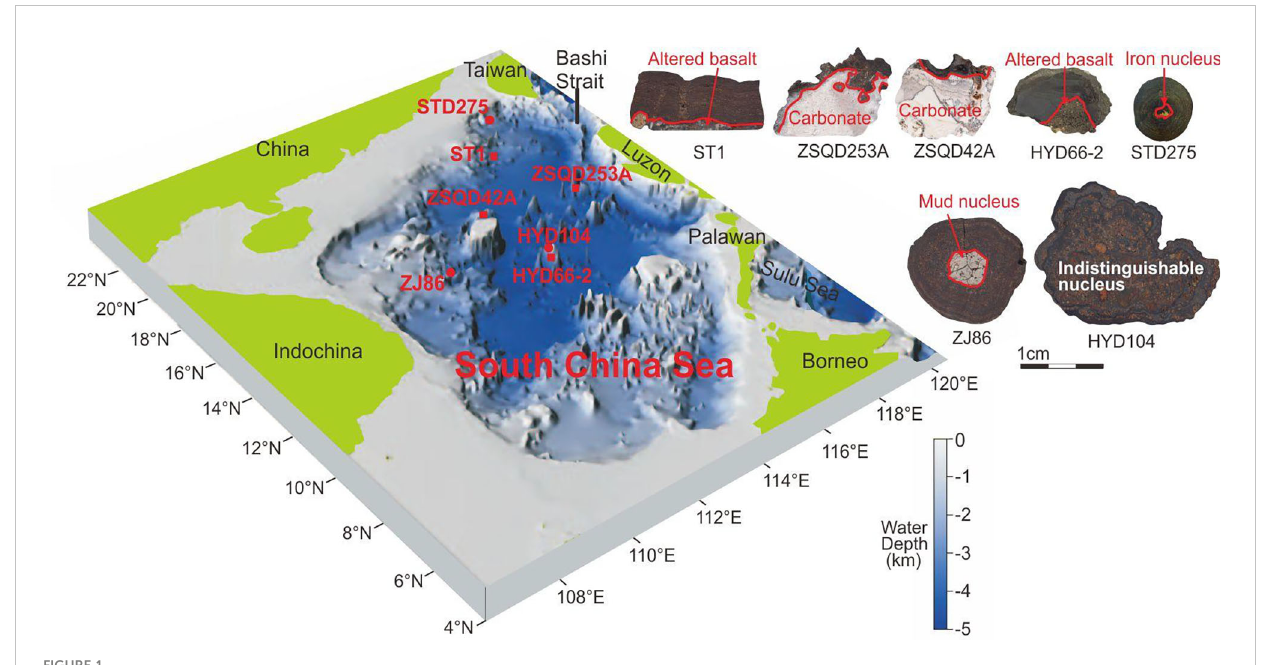
FIGURE 1 Location and topographic map of the South China Sea (Wang and Li,